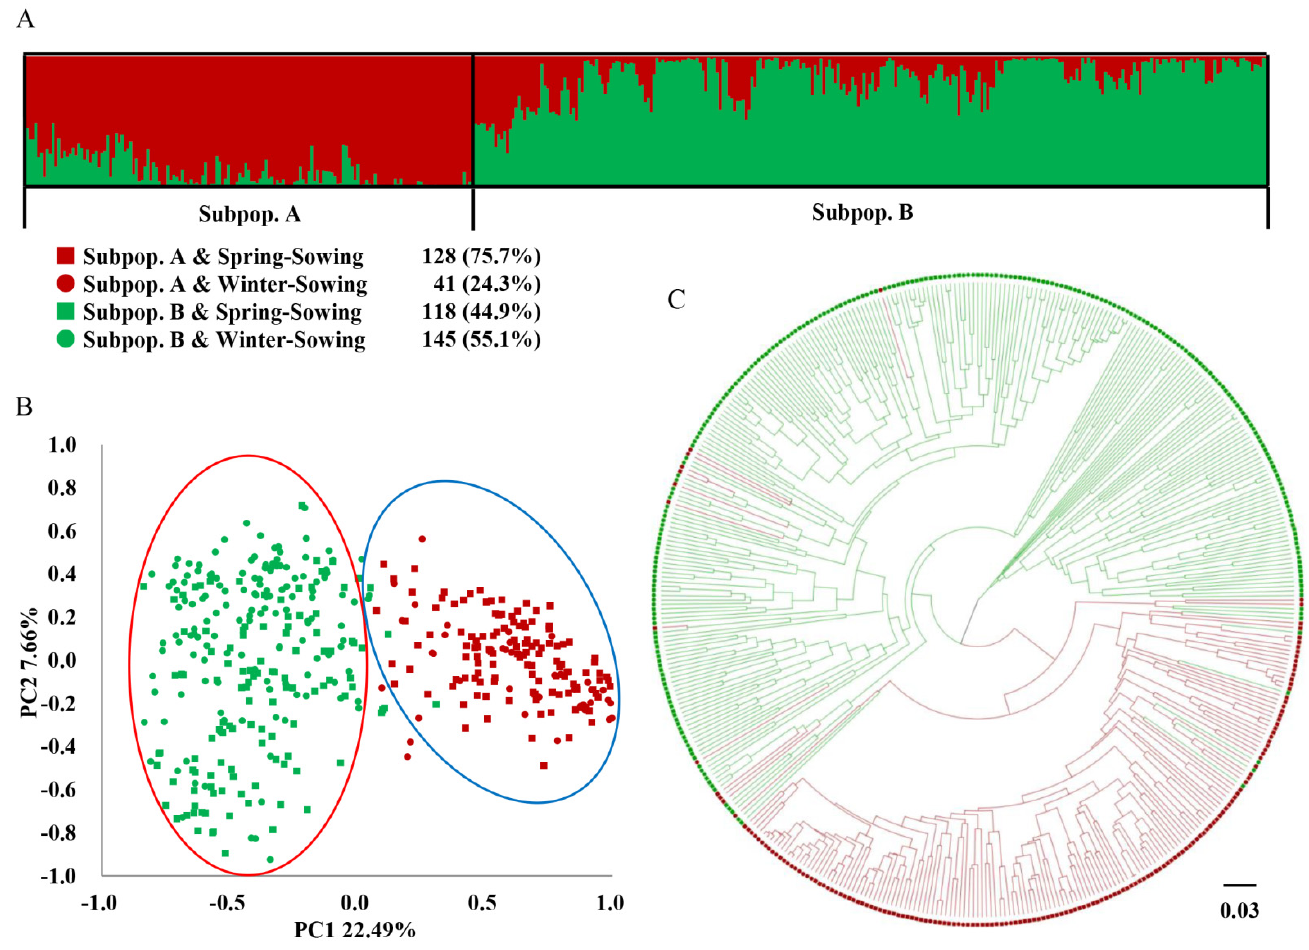
Figure 6. Population genetic structure of 432 pea accessions after HTS1 using neutral SNaPshot markers. ( A ) Structure analysis with 46 neutral SNaPshot markers. ( B ) PCoA with 46 neutral SNaPshot markers: the dark red squares represent the SS-type accessions of Subpopulation A and the dark red circles represent the WS-type accessions of Subpopulation A; the green squares represent the SS-type accessions of Subpopulation B and the green circles represent the WS-type accessions of Subpopulation B. ( C ) UPGMA tree based on Nei’s genetic distance with 46 neutral SNaPshot markers.